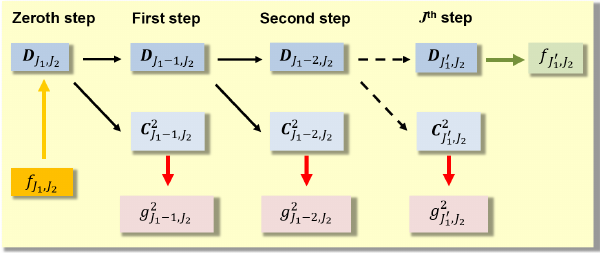
Figure 6. A 1-D MSR of the signal f J latitude ϕ . The “zeroth” step on the left-hand side conforms with the one in Fig.